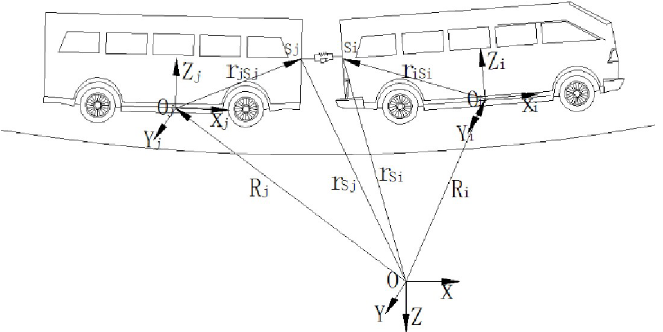
Fig 7. Spring-damper